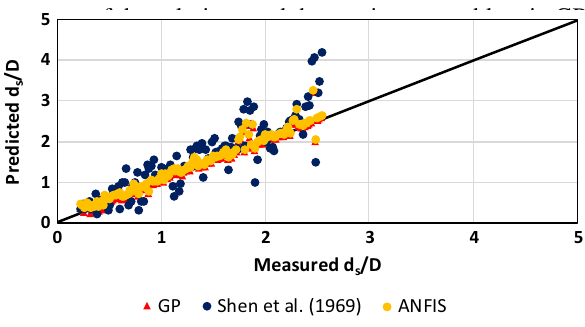
Fig. 3 ANFIS- and GP-predicted values of d ues for testing sets